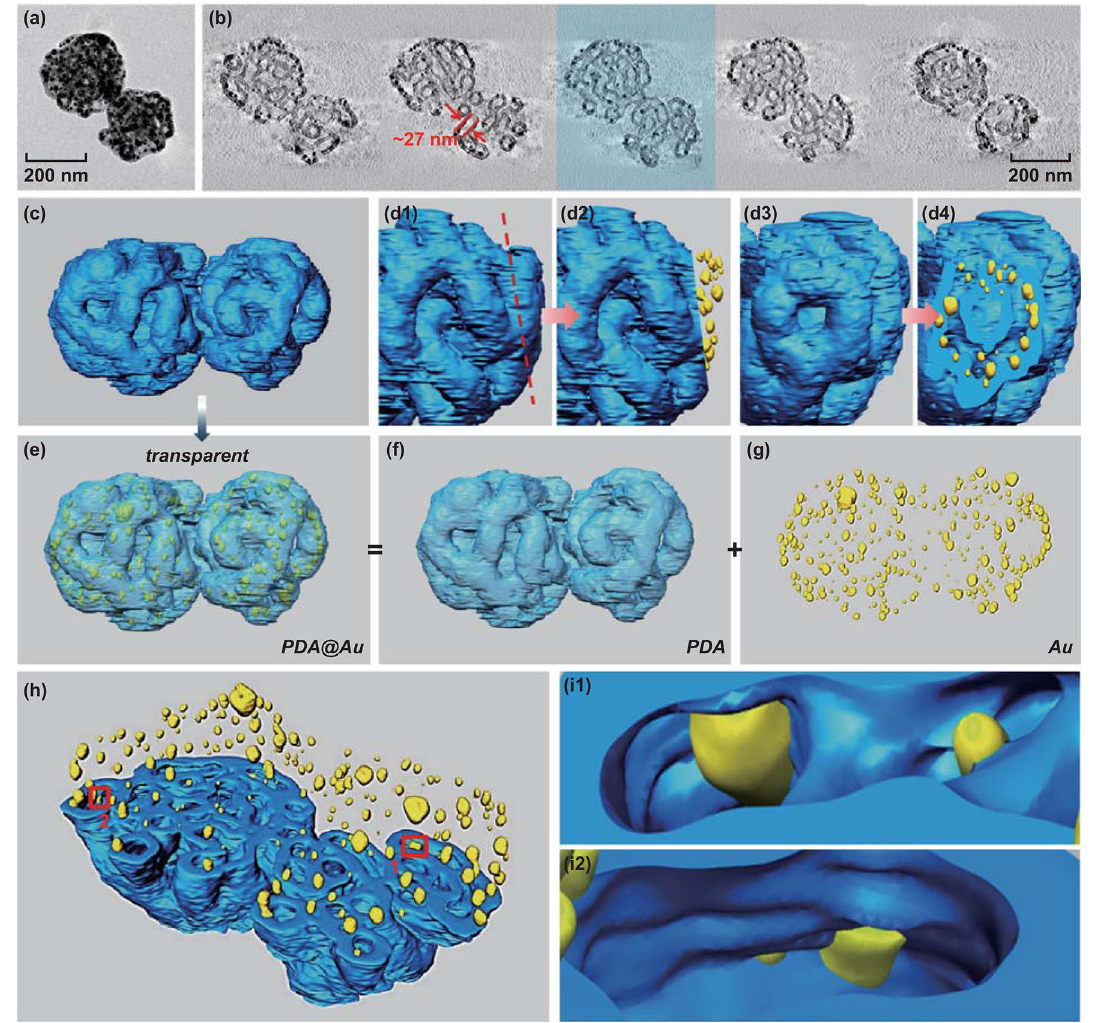
Fig. 5 TEM analysis of the Au@PDA particles: a normal TEM image and b selected XY slices through the tomographic reconstruction of two adjacent Au@PDA particles. c – i 3D surface renderings of the particles (PDA shown in blue and Au shown in yellow): c surface view ( d1 , d2 ) subregion including cut away view to highlight the interior distribution of gold nanoparticles in PDA ( d3 , d4 ) rotated view of d1, d2, respec‑ tively. e as c but with semitransparent PDA layer to show internal structure. f , g as e but components of PDA and Au are shown separately. h as c but with a cutting plane through the central XY slice of PDA. i1 , i2 magnified views of selected marked regions in h . (Color figure